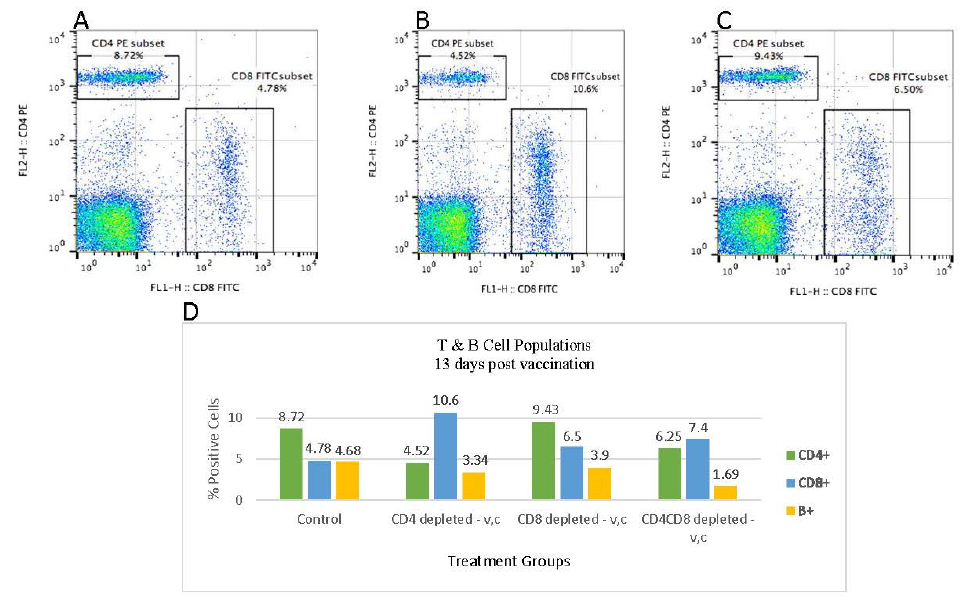
Figure 2. Recovery of CD4 + and CD8 + T Cells 13 days post-termination of antibody treatment. The percentage population of CD4 + and CD8 + T Cells in the control birds ( Panel A ), CD4 + T Cell depleted birds ( Panel B ), and CD8 + T Cell depleted group ( Panel C ) are depicted 13 days post-termination of antibody treatment. Blood samples from three birds per group were pooled, PBMC isolated, and 1 × 10 6 cells/100 µ L was used for cell surface antigen analysis. The CD4 + T Cells were stained with CD4-PE, and CD8 + T Cells were stained with CD8 α -FITC, 11–39 monoclonal antibodies. ( Panel D ) Bar graphs showing the percentage of B and T Cell populations 13 days after termination of antibody treatment. Comparative analysis was made between the untreated control and the T Cell depleted birds. Same total blood samples were used for the staining of B cells and double staining of CD4 + , and CD8 + T Cells. B cells, CD4 + T Cells, and CD8 + T Cells were stained with monoclonal antibodies Bu1-RPE, CD4-PE, and CD8 α -FITC, respectively. V: vaccinated; C: